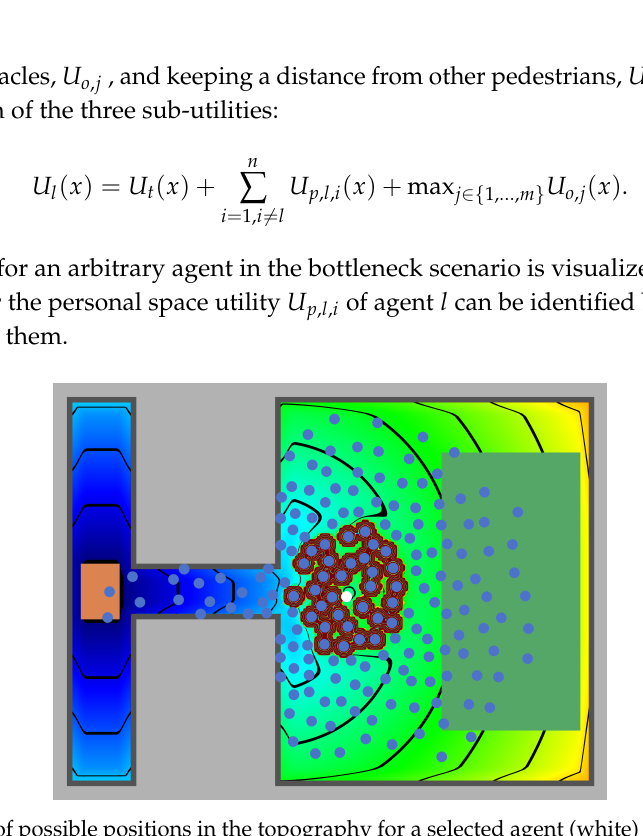
Figure 1. Utility of possible positions in the topography for a selected agent (white) modeling the goals of the agent: reaching its destination (orange square), avoiding obstacles (light gray areas), and keeping a distance to other agents (blue). Here, the (dark) gray areas contain the all positions with a low utility, not only the obstacle